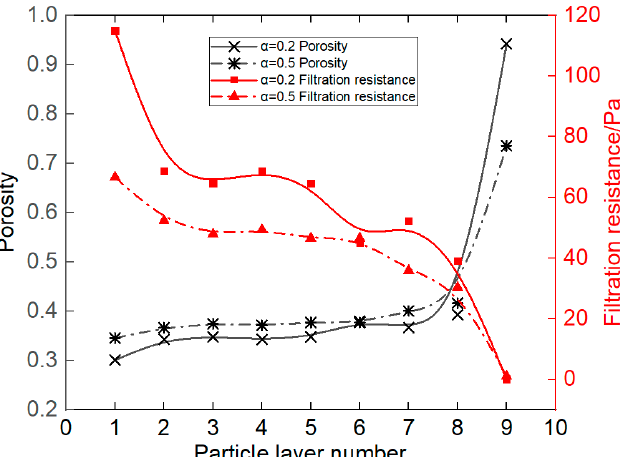
Figure 5. Effect of rolling resistance coefficient on average porosity and total filtration resistance of filter cake.